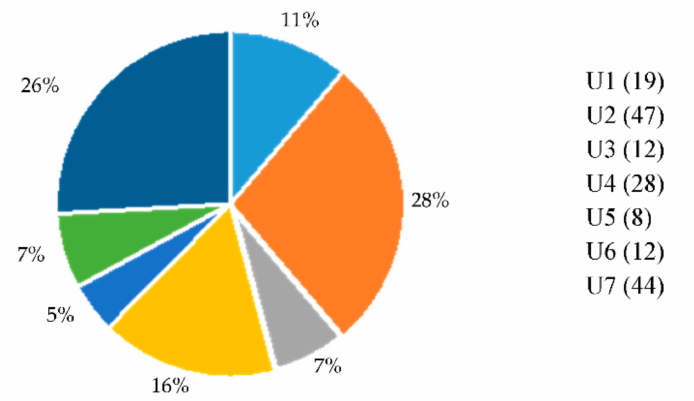
Figure 10. Participation by administrative unit. Source: own